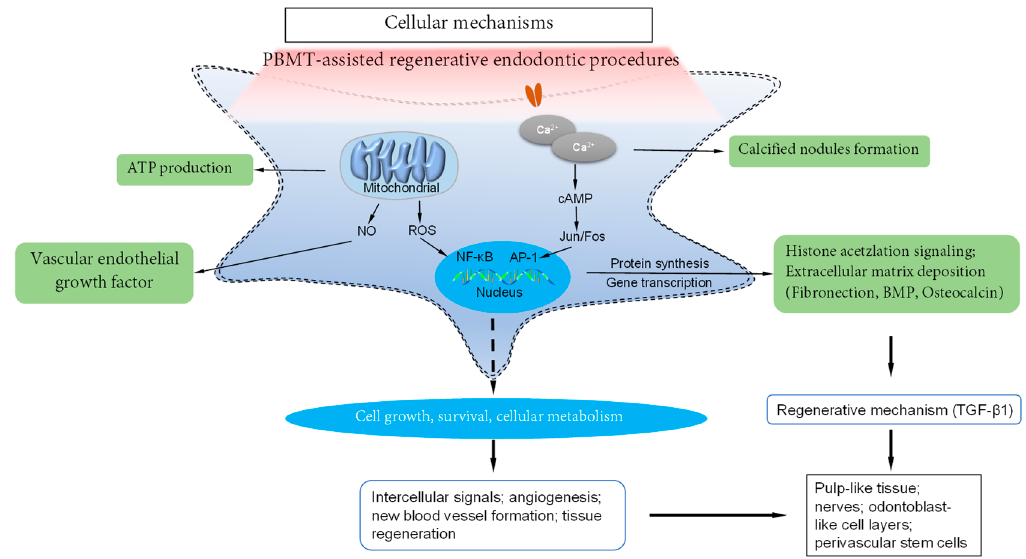
Figure 2. The cellular and molecular mechanisms of PBMT irradiation on DPSCs.